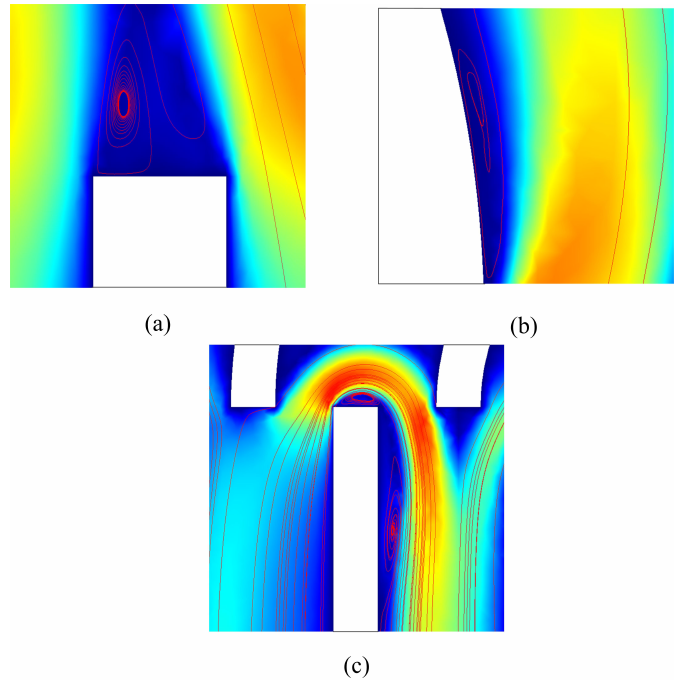
Figure 7. Recirculation areas at volumetric flow rate of 18 cm 3 s − 1 ( a ) After an offset fin, ( b ) In a curve and ( c ) In a U-turn (red lines show stream